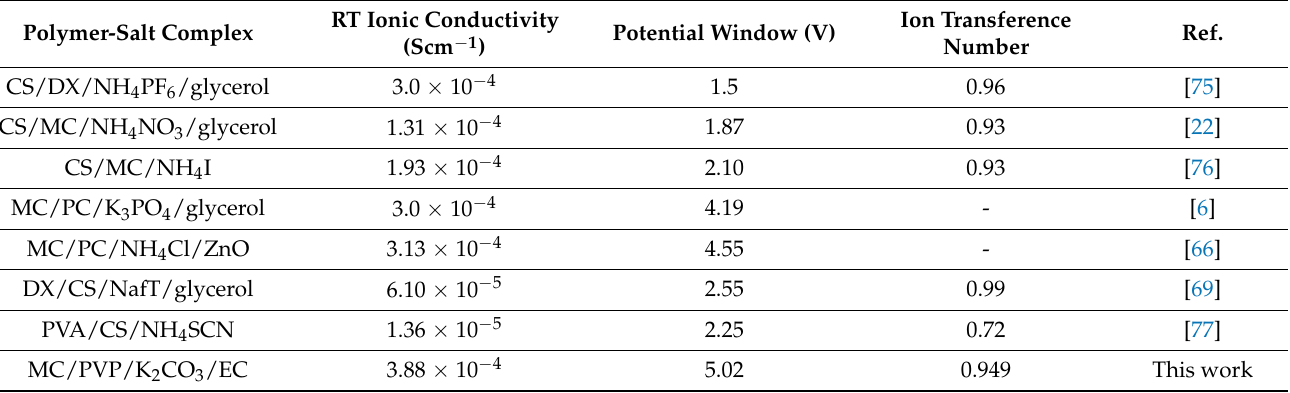
Table 2. Comparison of electrochemical performance of selected